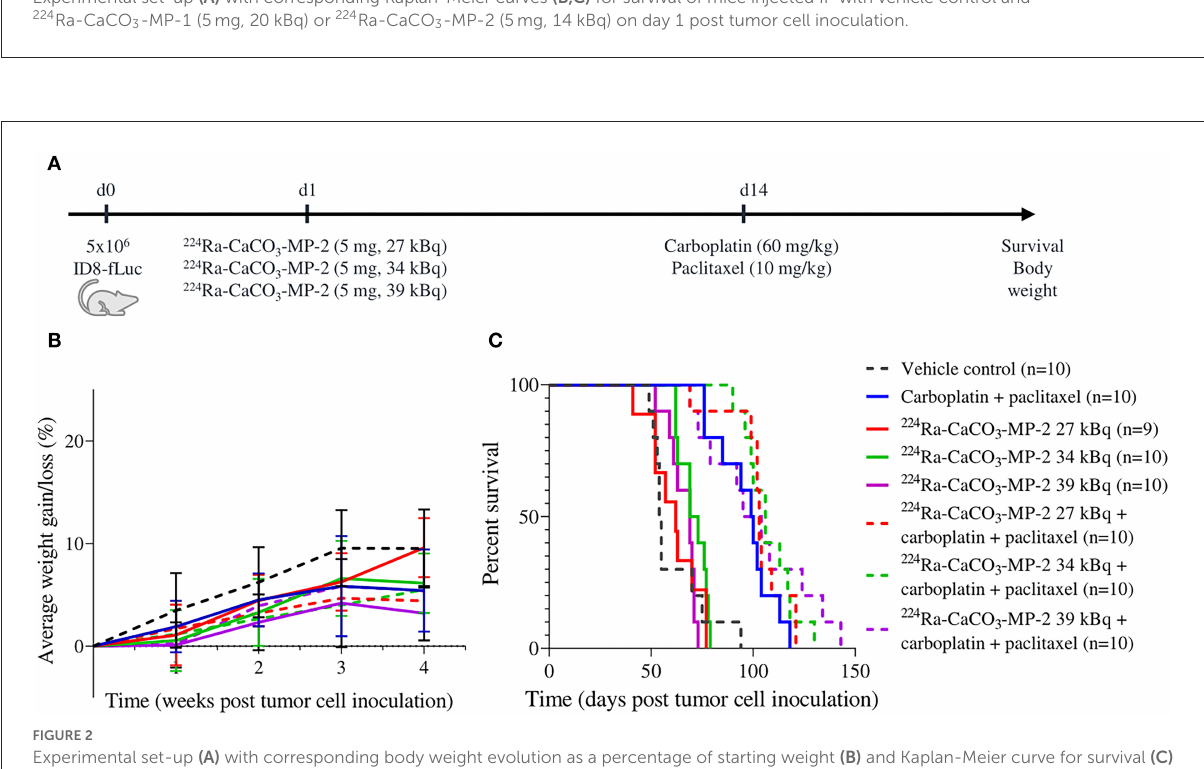
FIGURE2 Experimental set-up (A) with corresponding body weight evolution as a percentage of starting weight (B) and Kaplan-Meier curve for survival (C) of mice injected IP with vehicle control, 224 Ra-CaCO 3 -MP-2 (5mg, 27/34/39 kBq) on day 1 post tumor cell inoculation and/or carboplatin (60 mg/kg) and paclitaxel (10 mg/kg) on day 14 post tumor cell inoculation. Due to procedural complications during tumor cell inoculation (injection in visceral peritoneum instead of peritoneal cavity), one animal allocated to the 224 Ra-CaCO 3 -MP-2 27 kBq single treatment group was excluded from all further data